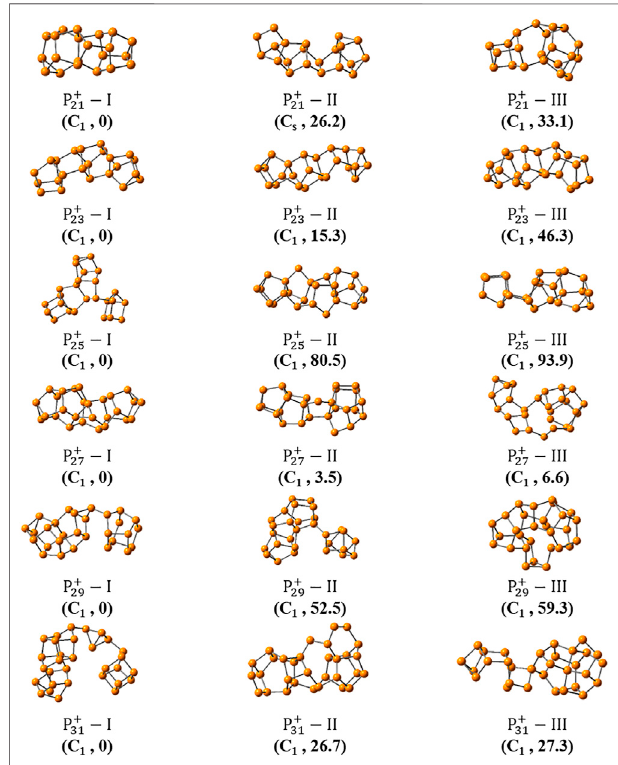
FIGURE 4 | The three most stable isomers of P + 2n + 1 ( n (cid:2) 10 – 15) searchedbytheNKCSprogram.Theirsymmetriesandrelativeenergies(inkJ/ mol) to corresponding global minima are shown